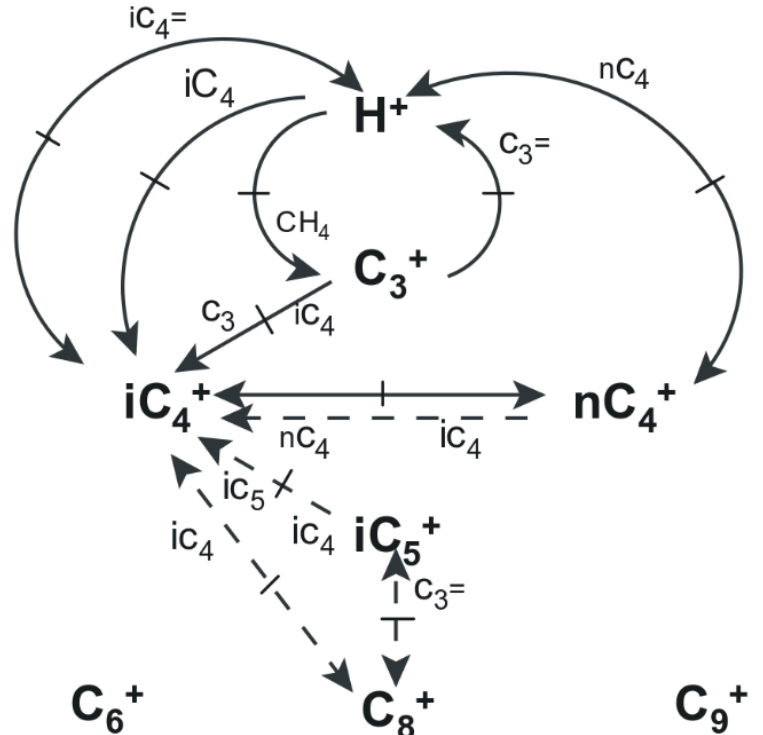
Figure 3. Catalytic cycles for cracking of isobutane over zeolite USY at 773K in assumed plug flow; solid lines denotes fast reactions, dotted lines denote slow reactions.Bold species are surface complexes and species next to the reaction line are gaseous products or reactants. Reaction lines indicate various elementary steps. (Redrawn from Yaluris et al. [69]).